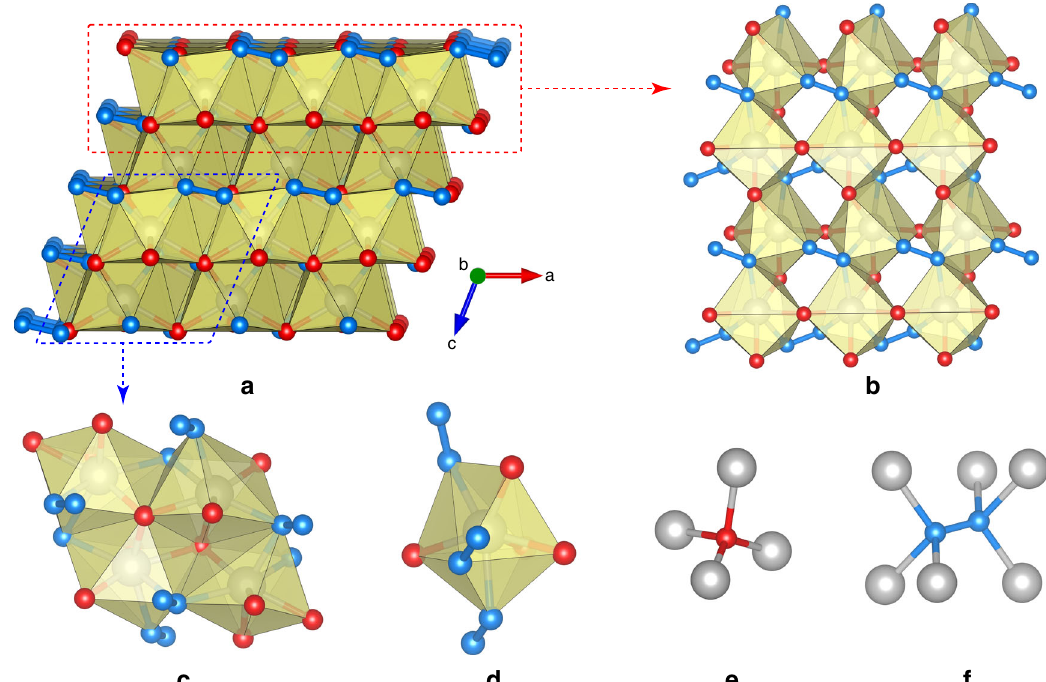
Fig. 1 Fragments of the crystal structure of Re 2 (N 2 )(N) 2 at ambient conditions. Re atoms – gr а y, N1 atoms – blue, N2 atoms – red. ReN 2 crystallizes in the space group P 2 1 / c (No. 14) with a = 3.6254(17), b = 6.407(7), c = 4.948(3) Å, β = 111.48(6)°. Rhenium and nitrogen atoms occupy Wyckoff Positions 4 e : Re [0.35490(11), 0.34041(8), 0.19965(8)], N1 [0.194(2), 0.038(2), 0.311(19)], N2 [0.259(3), 0.6381(18), 0.024(2)]. Full crystallographic information is given in the supplementary crystallographic information fi le and in the Supplementary Tables 2 and 3. a The projection of the crystal structure along the b -axis. b , c Fragments of the crystal structure of ReN 2 showing how ReN 7 polyhedra are connected with each other. d Separate ReN 7 coordination polyhedron. e Coordination of N2 atoms. f Coordination of N1 – N1